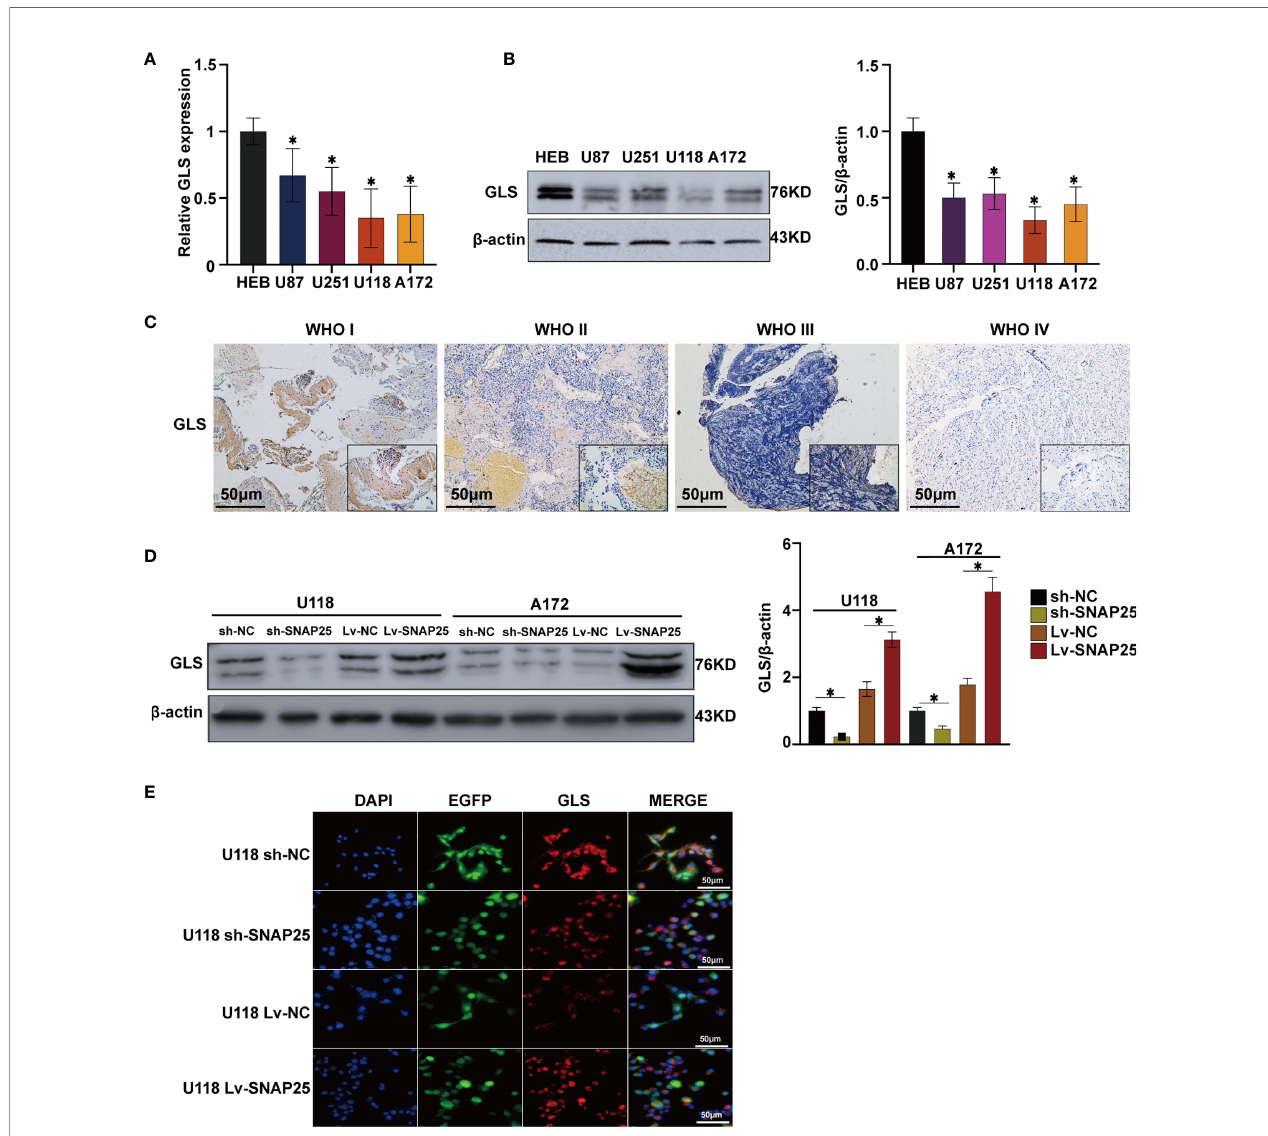
FIGURE 5 | SNAP25 functions as an ef fi cient sponge in glioma. (A, B) RT-qPCR (A) and western blot (B) analysis of GLS expression level in glioma parental cell lines and NHA, * p < 0.05 compared with NHA cells. (C) Representative images of SNAP25 expression from glioma tissues and nontumor tissues by ISH assays. (D) – Western blot analysis of GLS expression level in U118 and A172 glioma cell lines transfected with sh-NC, sh-SNAP25, Lv-NC and Lv-SNAP25, * p < 0.05 compared with Lv-NC or sh-NC group. (E) Immuno fl uorescence staining of GLS in SNAP25-transfected